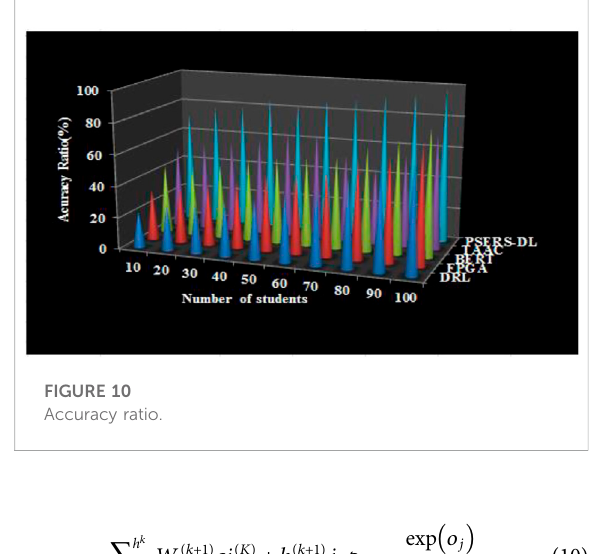
Figure 6 signi fi es the softmax function. A deep neural network (DNN) is quali fi ed for identi fi cation to increase the prediction error over the data, which is equivalent to reducing the cross-entropy optimization problem in Eq. 11: